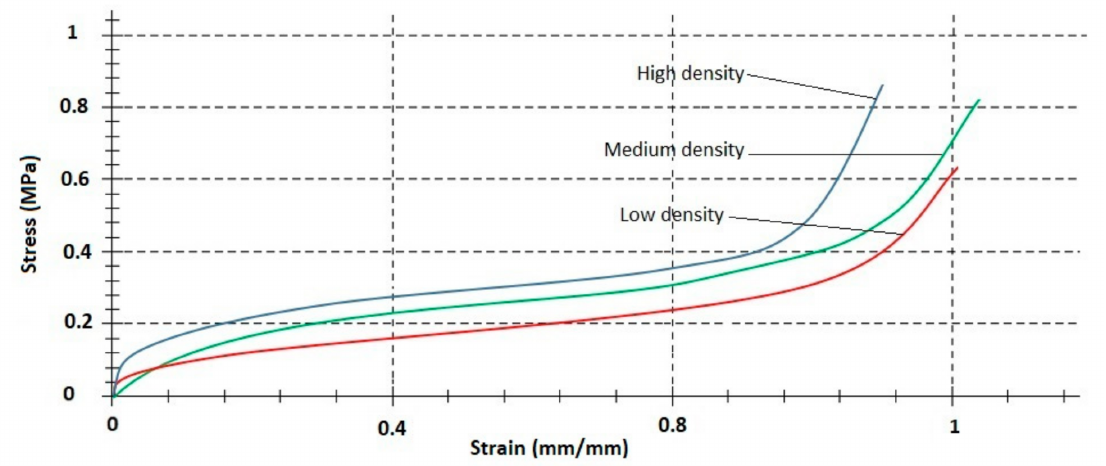
Figure 7. Comparison strain of representative stress–strain curves at strain rate 25 mm/s for low (20 g/dm 3 ), medium (80 g/dm 3 ) and high (200 g/dm 3 ) density EPP